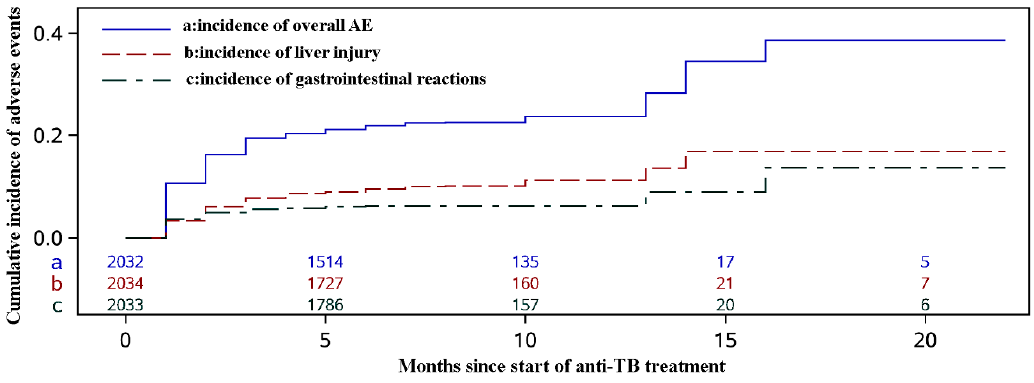
Figure 1. Cumulative probability of adverse events (AE) since start of anti-TB treatment.